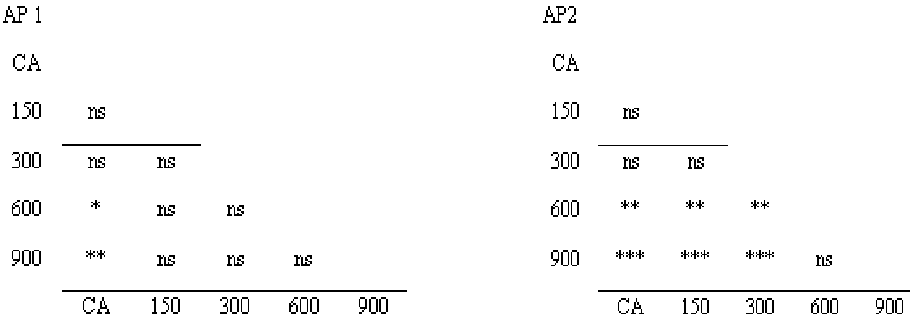
Figure 6. Student t-test applied between studied doses of neomycin (150–900 mg / L) and control group (CA) for two studied appendixes. AP1—the first pair of anal papillae, AP2—the second pair of anal papillae, * p < 0.05, ** p < 0.01, *** p < 0.001, ns— p > 0.05.